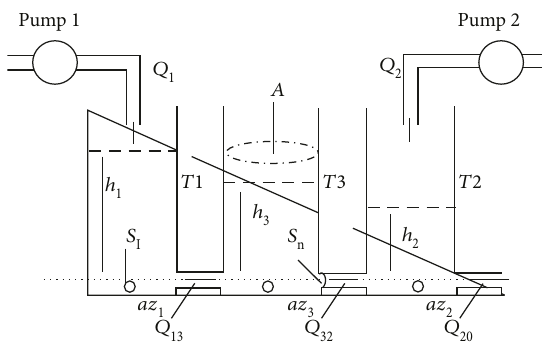
Figure 3: Principle structure to de fi ne the variables and parameters of